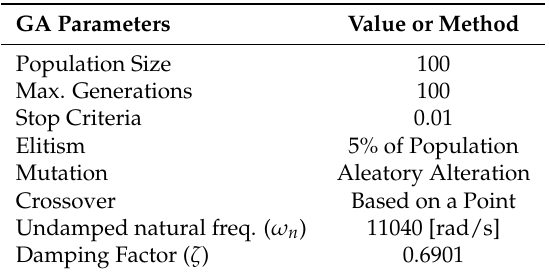
Table 4. GA and poles placement method.